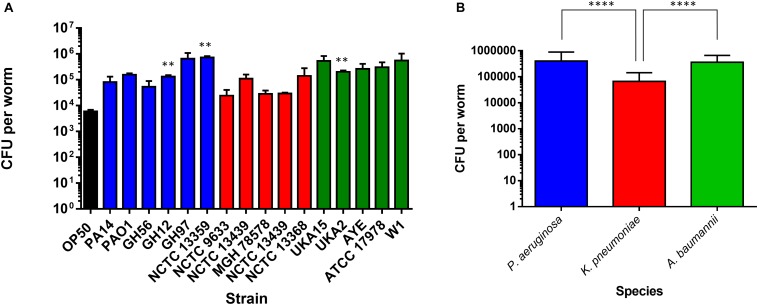
Colonization of the C. elegans intestine by bacterial pathogens. The ability of strains of P. aeruginosa, K. pneumoniae, and A. baumannii to colonize the C. elegans intestine was measured after 48 h exposure (A) and compared to E. coli OP50. These experiments were performed in at least triplicate for all strains. Error bars represent ± SEM. Analysis is by one-way ANOVA with Tukey’s multiple comparison. Significance relative to OP50 is shown. Comparison of mean CFU per species of bacteria in colonization of C. elegans after 48 h exposure (B). Error bars represent ± SEM. Analysis is by student’s unpaired t-test and significance relative to the other bacterial species is shown. ∗P < 0.05, ∗∗P < 0.01, ∗∗∗P < 0.001, ****P < 0.0001.